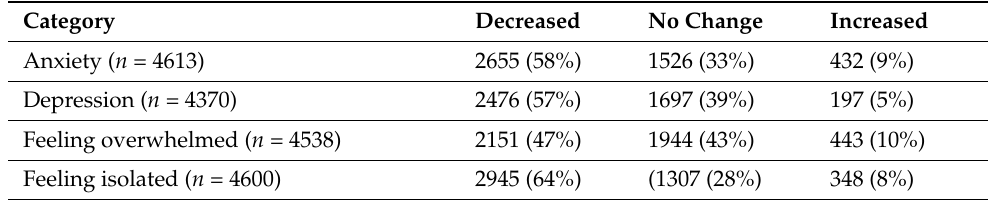
Table 3. Companion animal impact on COVID-19 related